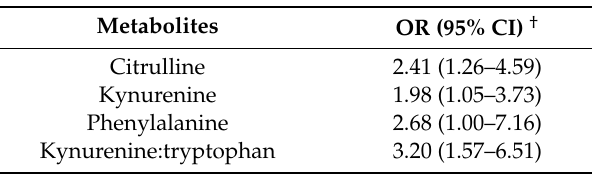
Table 5. Association between metabolites and CKD incidence after eight years.